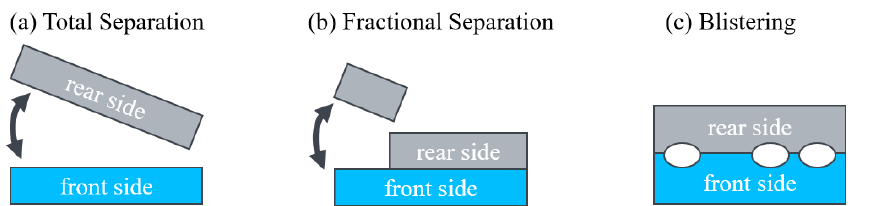
Figure 2. Different types of delamination during the leaching process: ( a ) Total separation (observed for CdTe and a-Si module pieces). The front side is completely separated from the rear side. ( b ) Fractional separation (observed for CIGS and c-Si module pieces). Only small parts of the rear side are separated; the major part of the module structure is still intact. ( c ) Blistering (only observed for c-Si module pieces). Bubble formation emerges locally on the front side of c-Si module pieces, either between glass and EVA or between EVA and solar cell depending on the pH. In this case, no separation occurs between the front and the rear